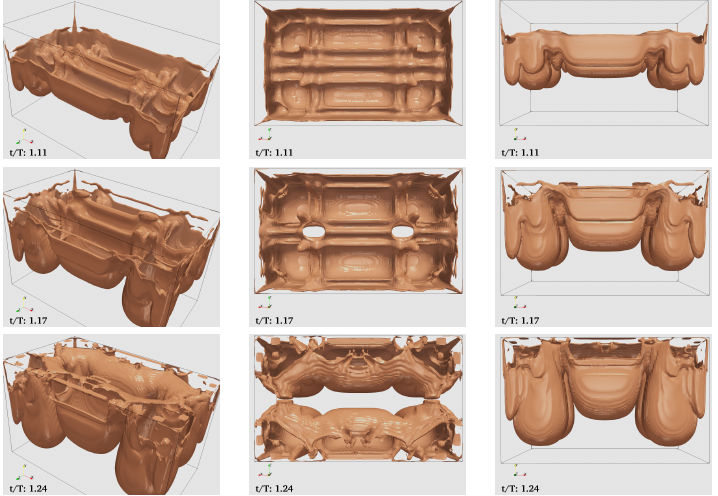
Figure 27. Three-dimensional oil E LEMENTAL ® results on the N 50 resolution at various time instants prior to and shortly after the first roof